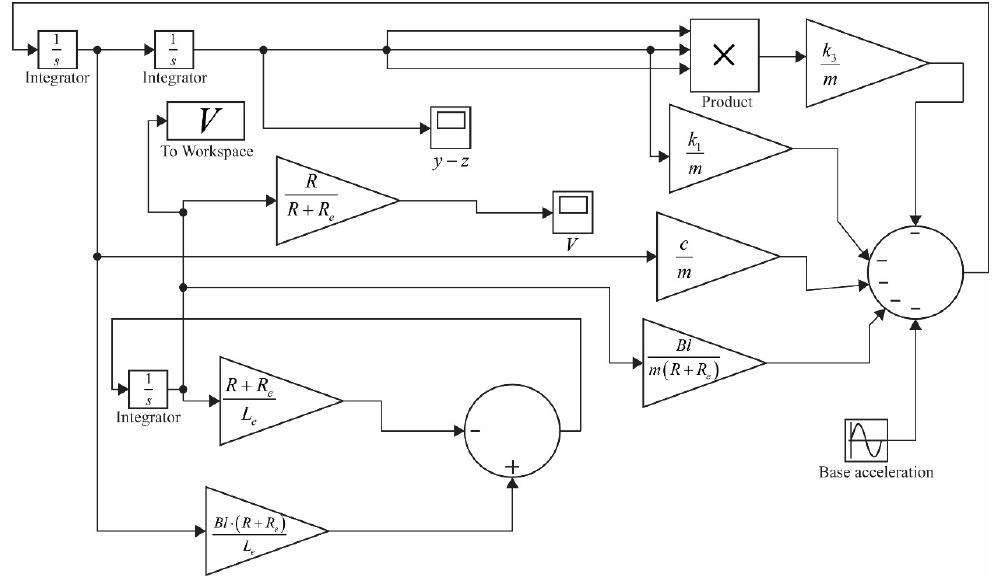
Figure 2. Matlab Simulink code schematic for Equation (7) for prediction of the oscillator relative displacement response ( y − z ) and output voltage v from the base excitation acceleration time domain integration method.